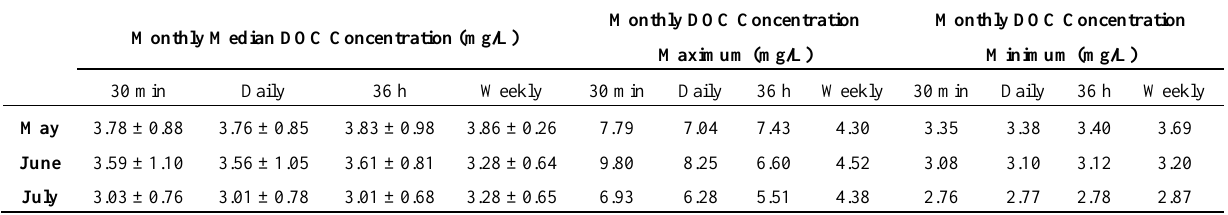
Table 1. Effect of measurement frequency on descriptive statistics.